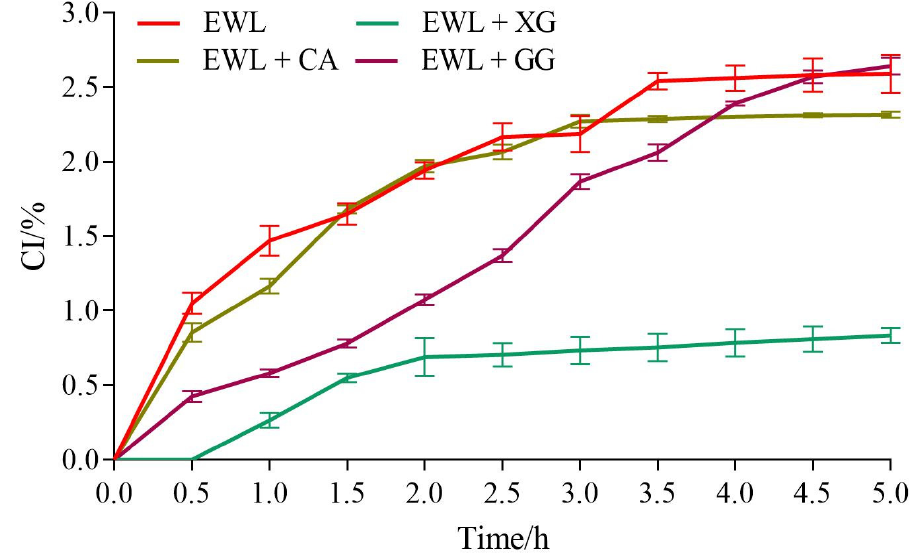
Figure 5. The effects of polysaccharide added to egg white liquid on CI.